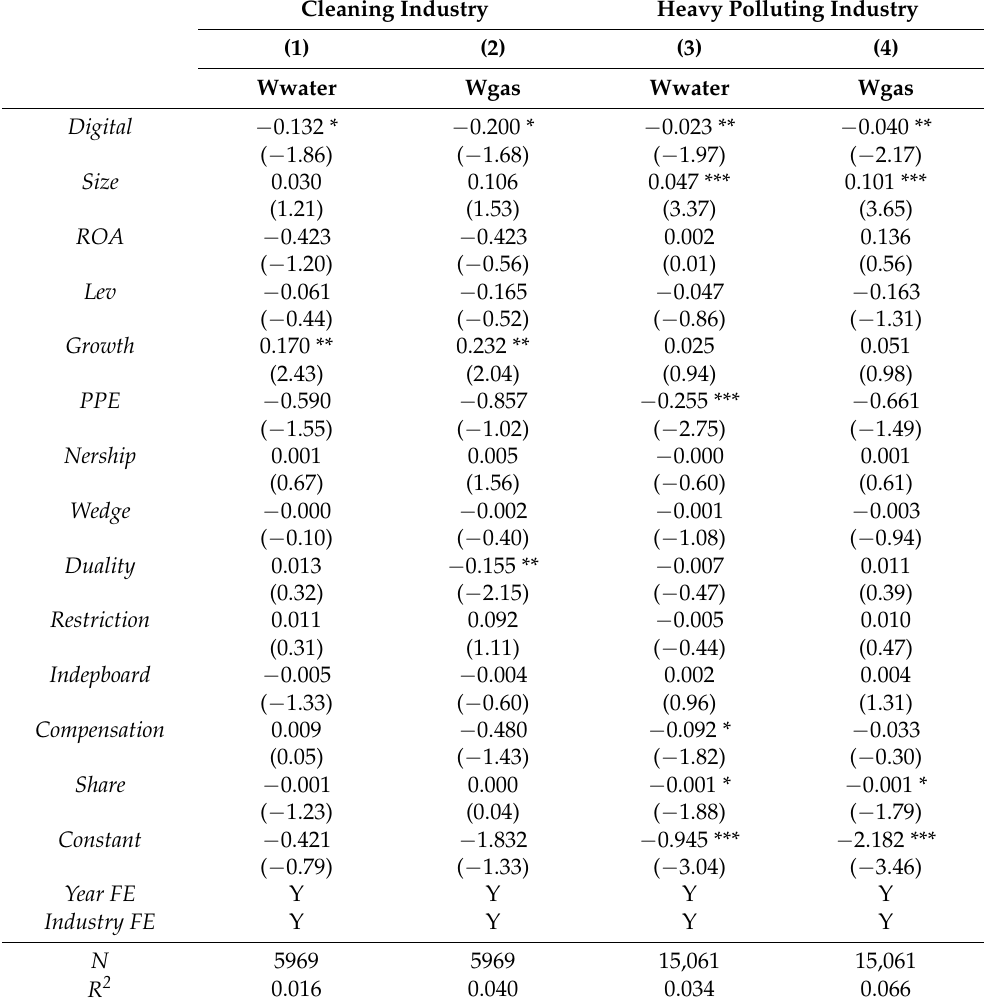
Table 8. Cross-section analysis: The effect of industry heterogeneity. This table reports the results of OLS regressions examining the effect of digital transformation on environmental pollution. In columns 1–4, we split the samples into clean industry group and heavy-polluting industry group. Appendix A provides definitions of variables. The regressions control for a year and industry fixed effects. In parentheses are t -statistics based on standard errors adjusted for heteroskedasticity and firm